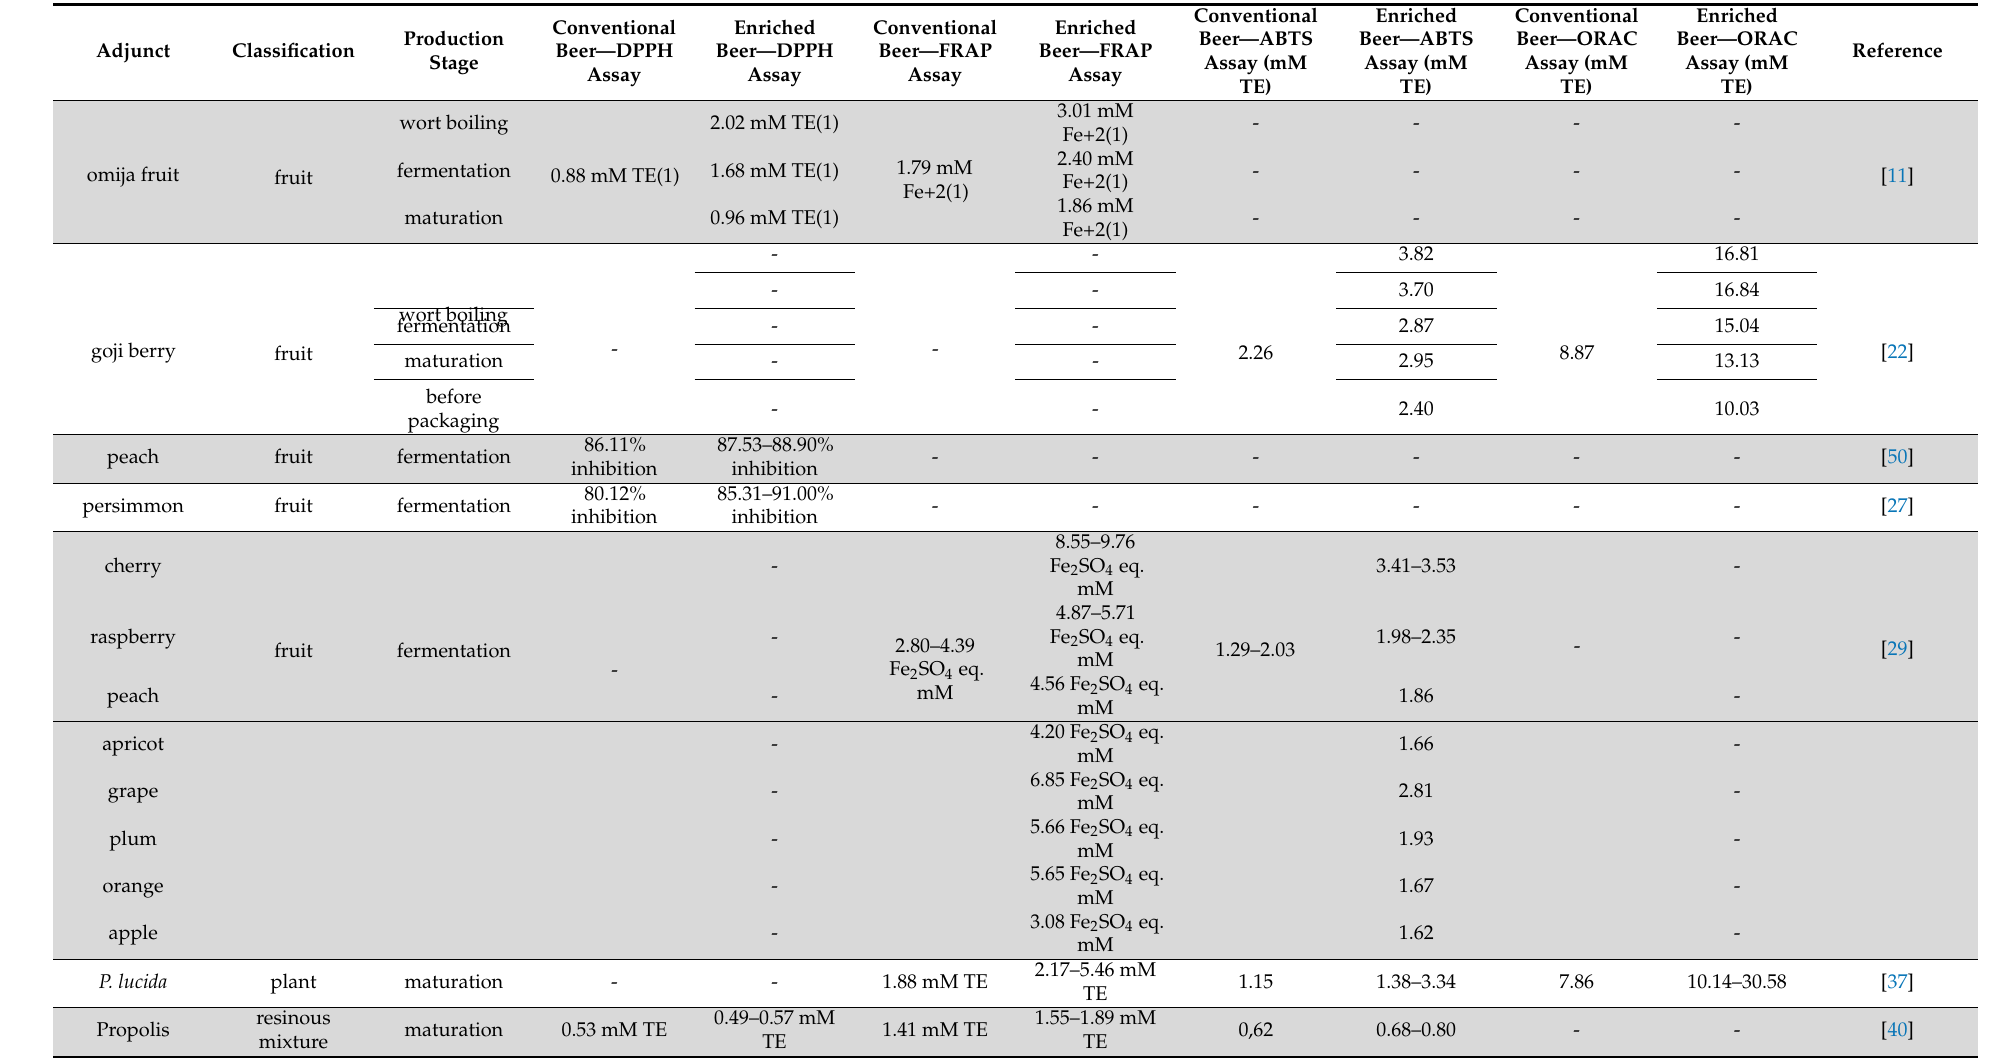
Table 2. Comparison of adjunct used, production stage of insertion, and resultant antioxidant